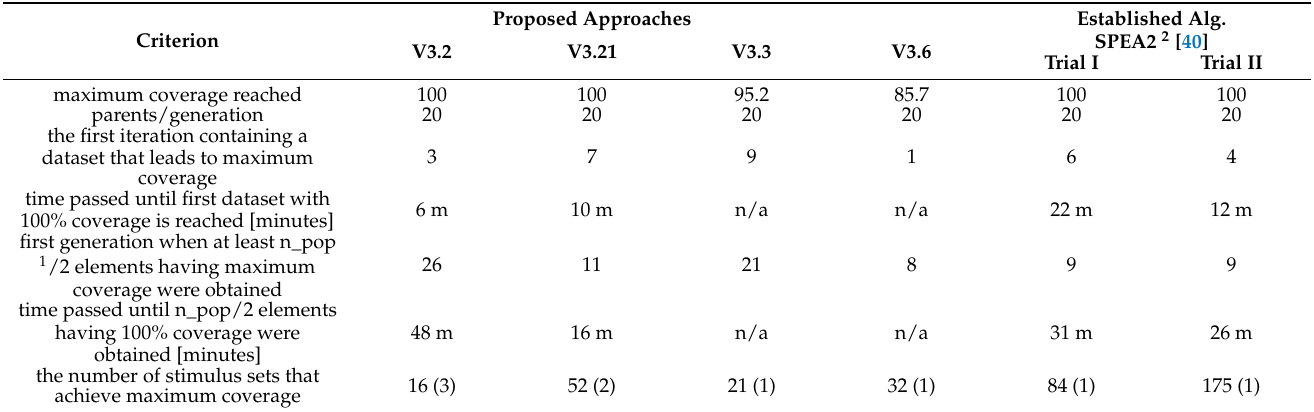
Table 3. Results related to the main coverage target when the mutation percentage was set to a value of 5% value for each iteration of the